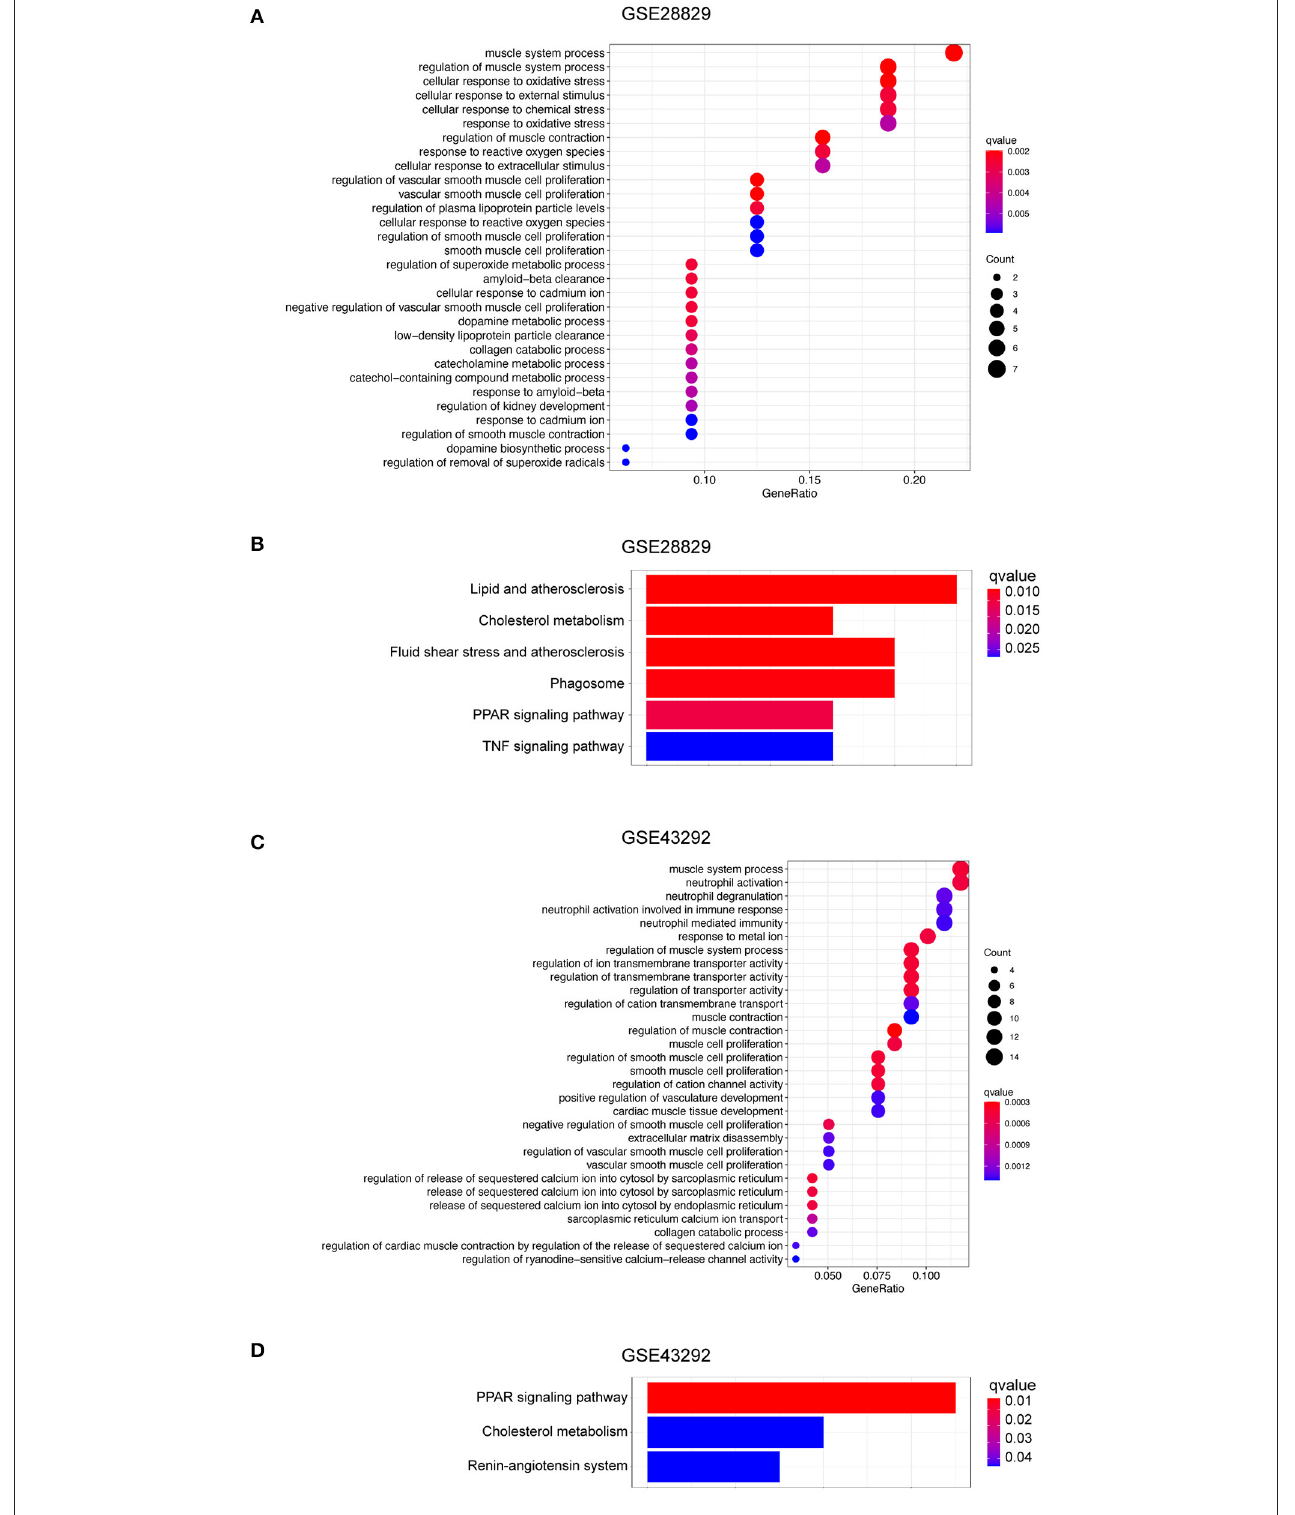
FIGURE 6 | Function and pathway enrichment analysis of DEGs in HMOX1 high-expression group. The GO (A) and KEGG (B) enrichment analyses of DEGs in GSE28829. The GO (C) and KEGG (D) enrichment analyses of DEGs in GSE43292.